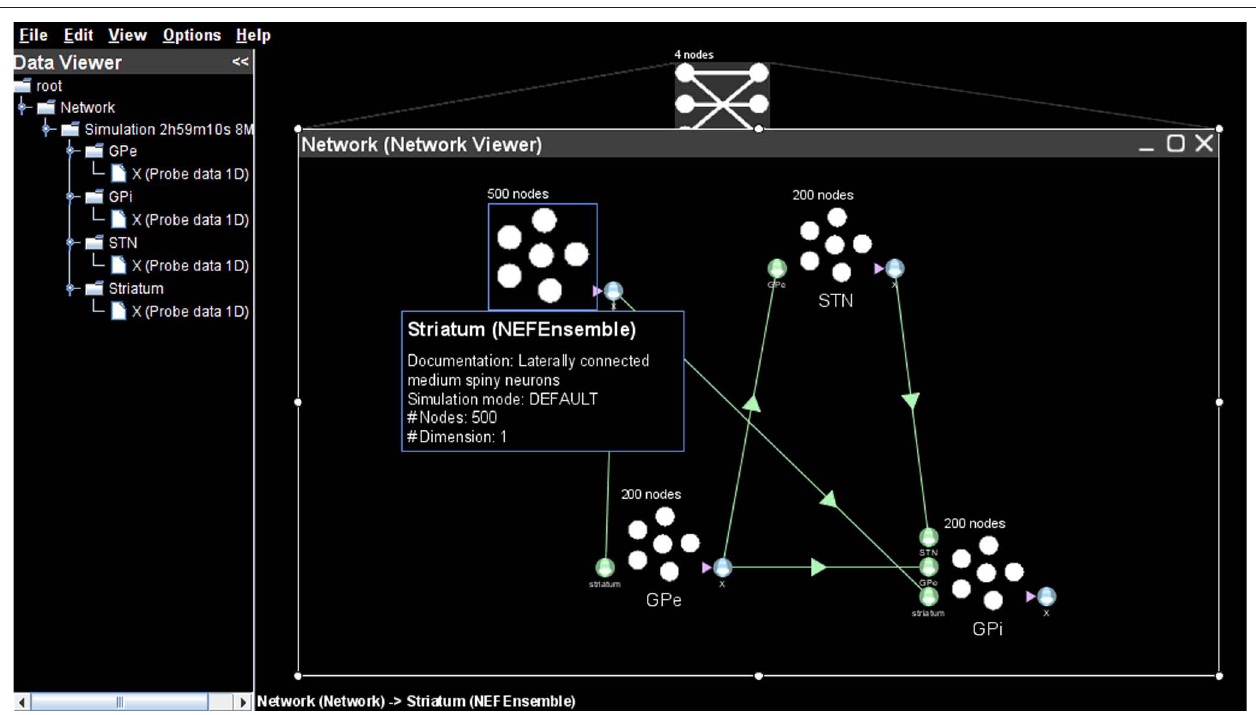
FIGURE 1 | A neural model of the basal ganglia developed in Nengo.